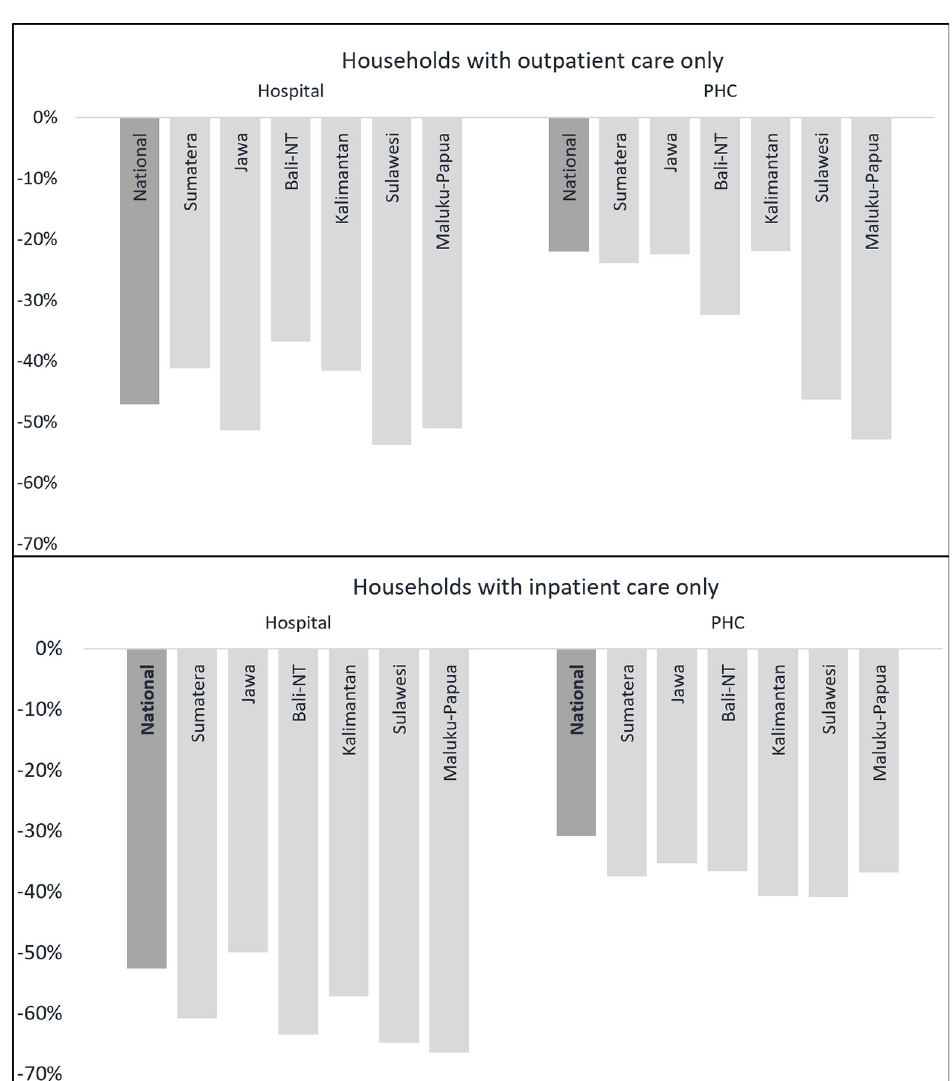
Fig 5. JKN’s effect on reducing OOP payments by facility and care type at the provincial level. Note: � Statistically significant at 5%.